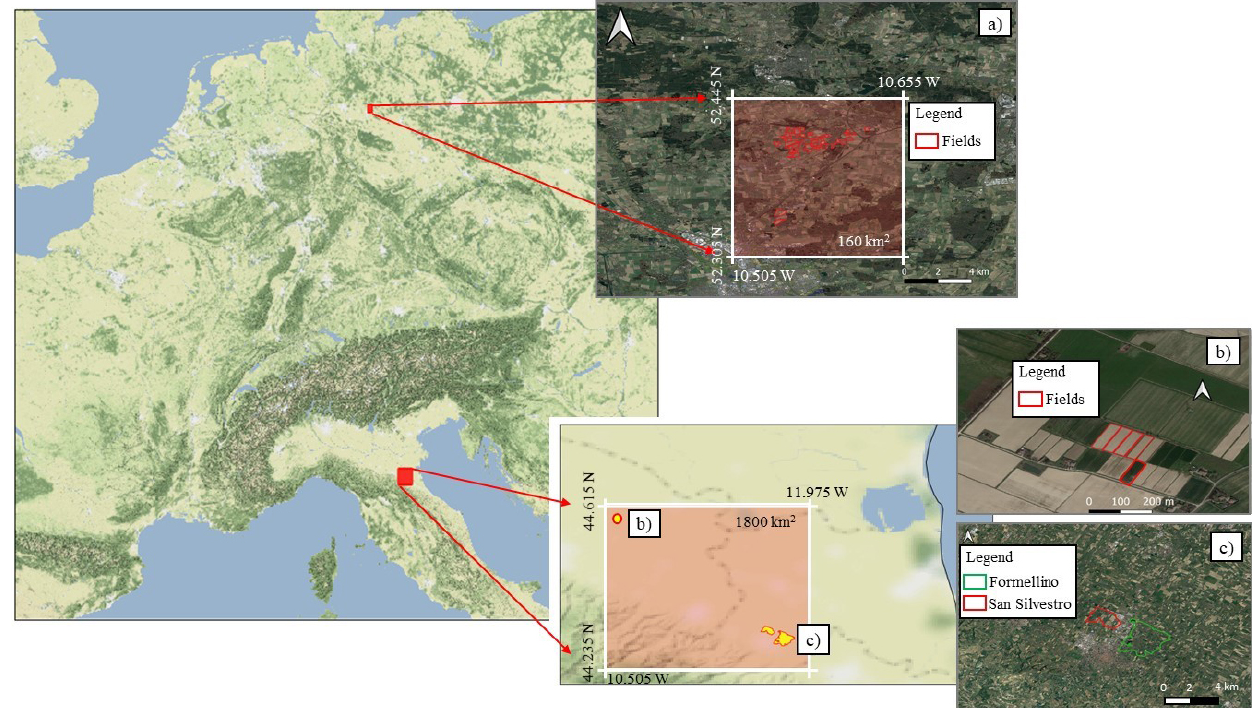
Figure 1. Study area composed of the German and Italian pilot sites (represented by the red boxes). The pilot sites include three test sites: (a) Lower Saxony with 49 fields; (b) five fields in Budrio; and (c) two small districts close to the city of Faenza, called San Silvestro and Formellino. Map data © Google Maps